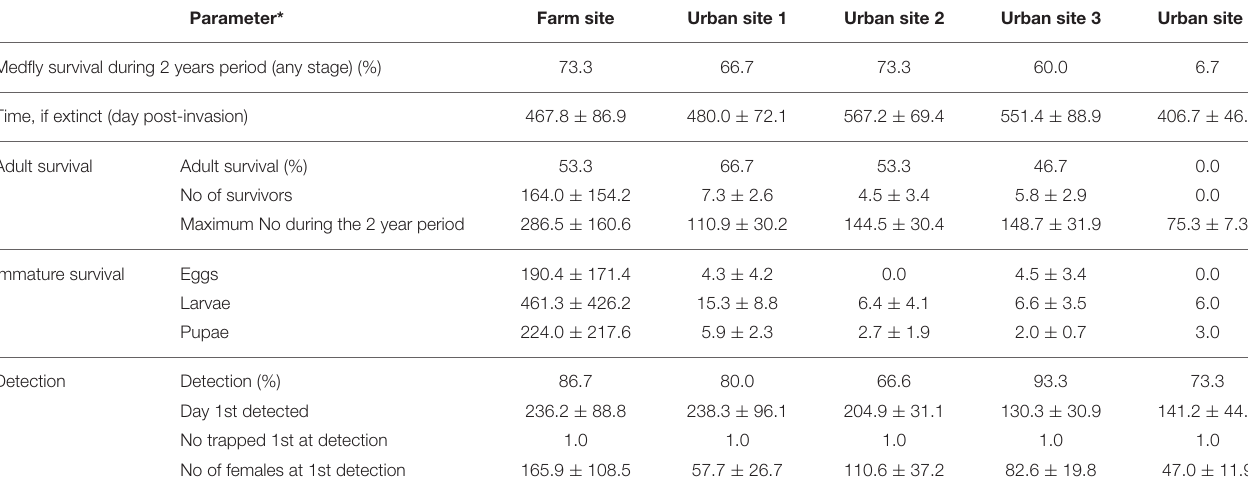
TABLE 5 | Propagule establishment and detection: Single 100 female cohort, emerging from centrally “abandoned fruit”*.